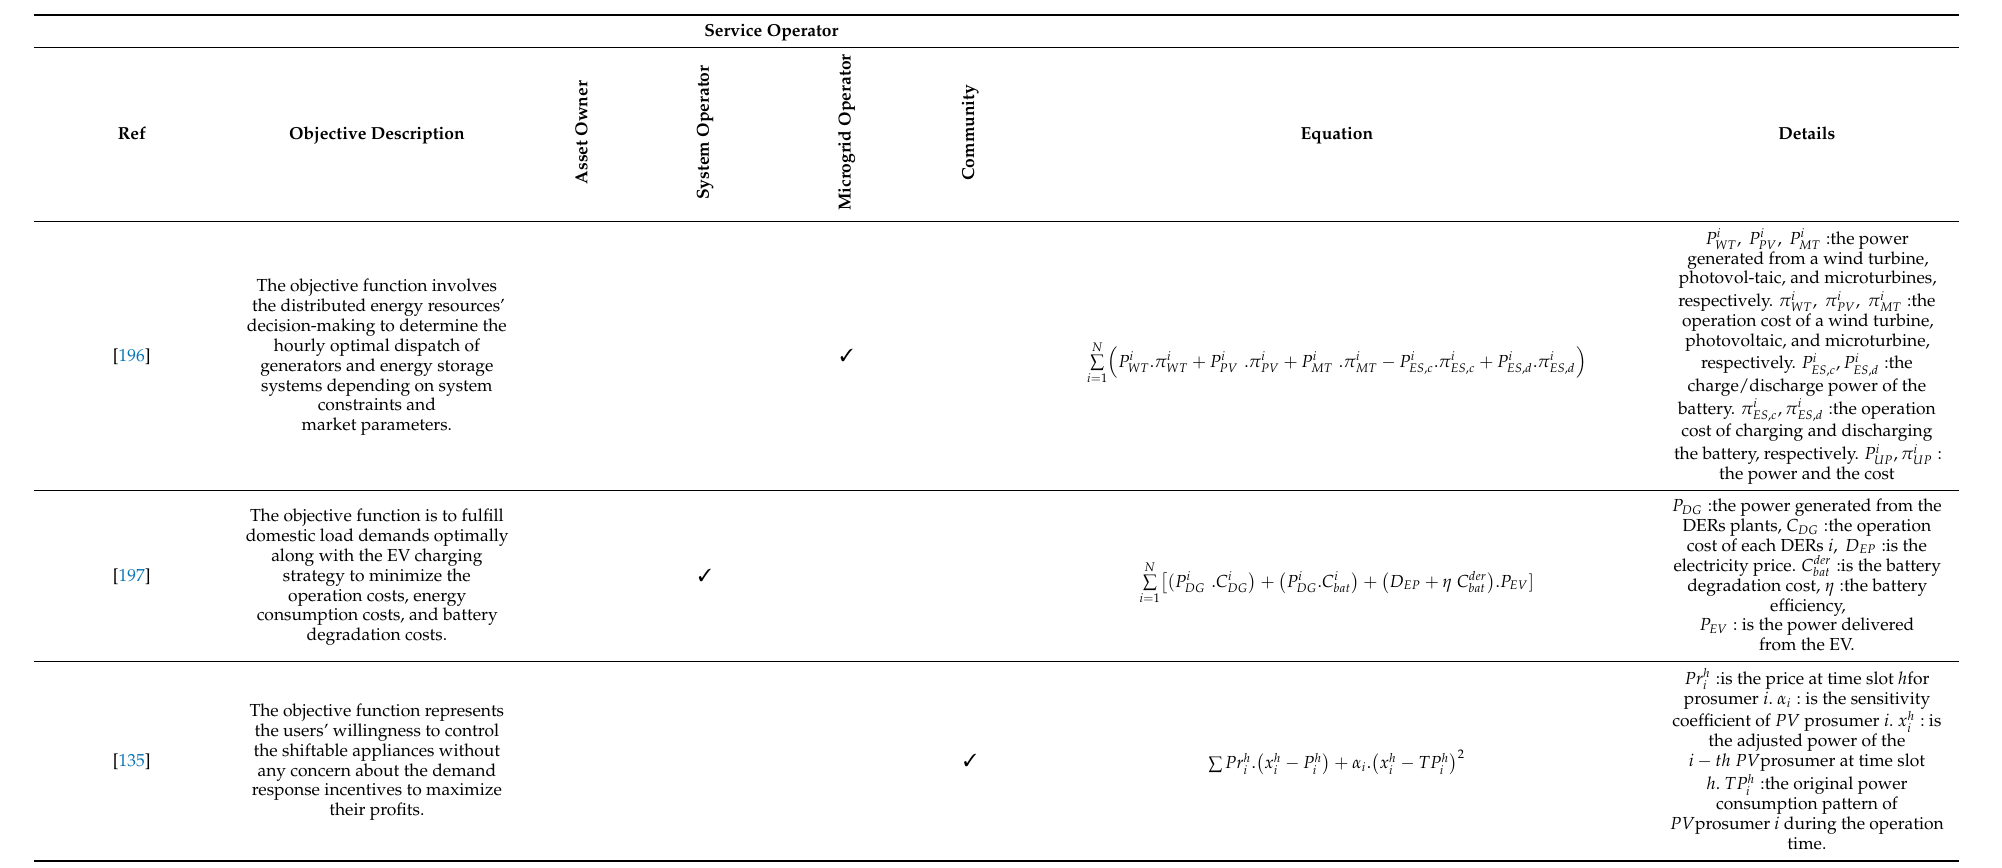
Table 8. The objectives function related to the energy market and energy